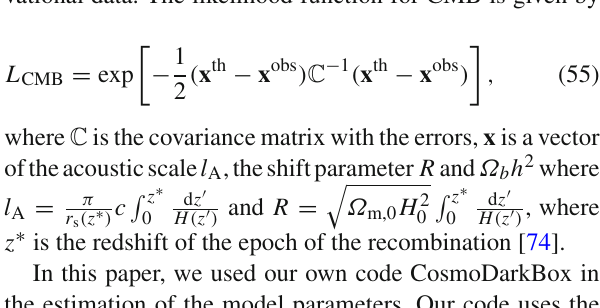
(cid:3) ( z ) z d z (cid:17) and AP ( z i ) obs are 0 z H ( z (cid:17) )